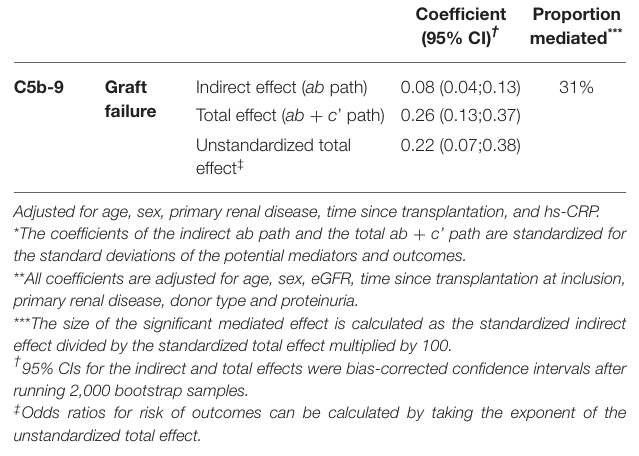
TABLE 4 | Mediation analyses of the impact of sC5b-9 on the association between properdin and graft failure. Potential Outcome Effect mediator